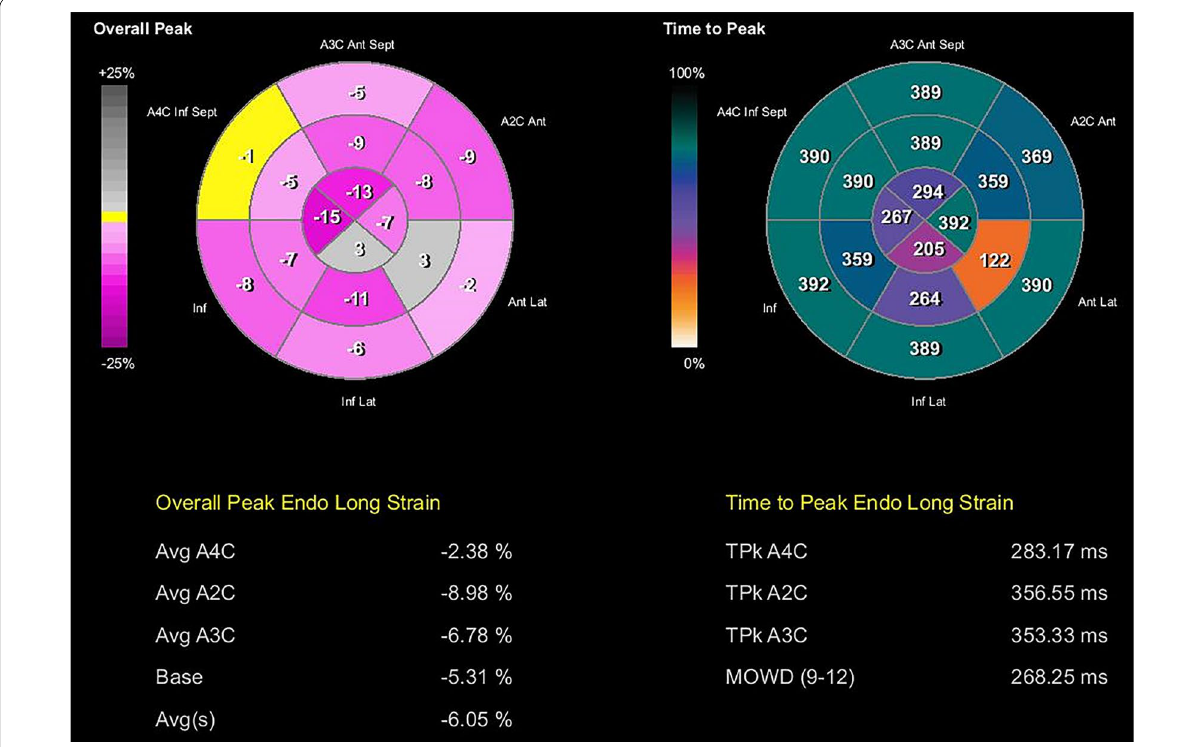
Fig. 6 Bull’s eye plot of left ventricular longitudinal strain and time to peak longitudinal strain